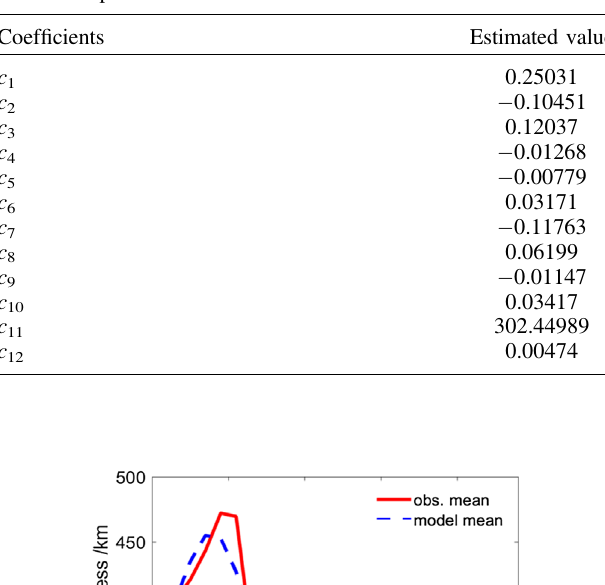
Table 1. Optimal set of coef fi cients.